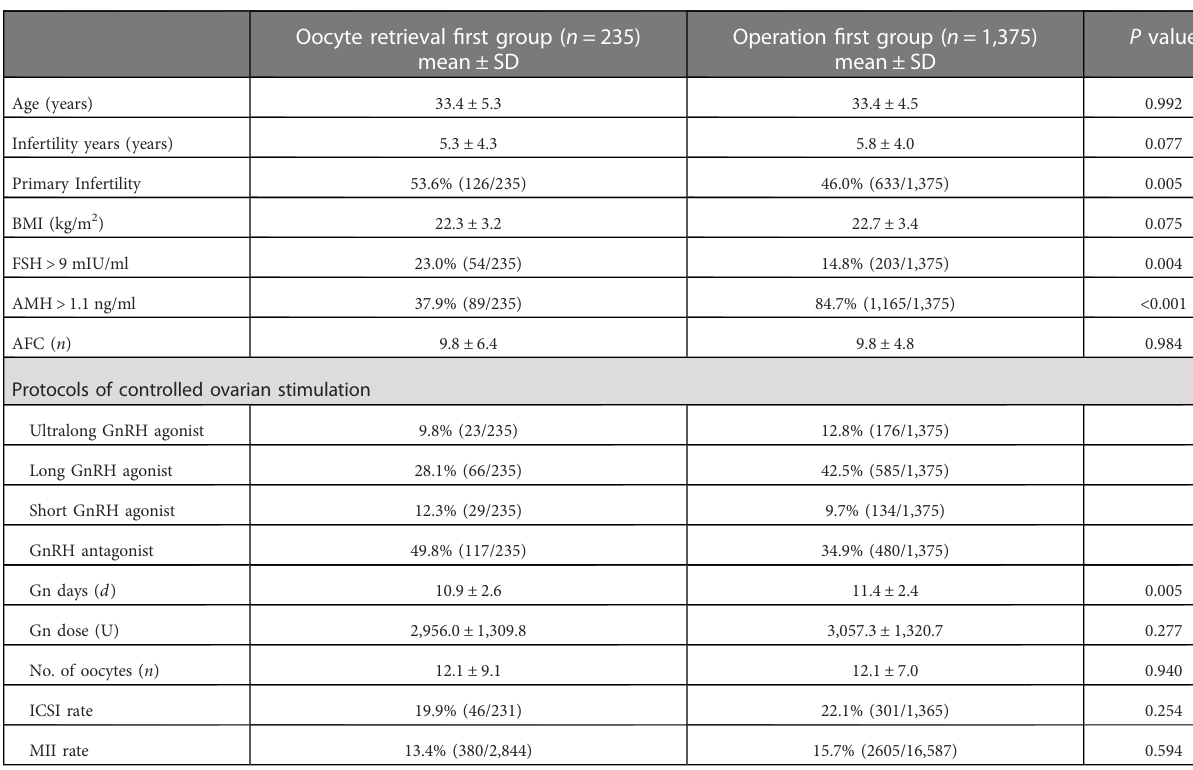
TABLE 1 The general characteristics of two